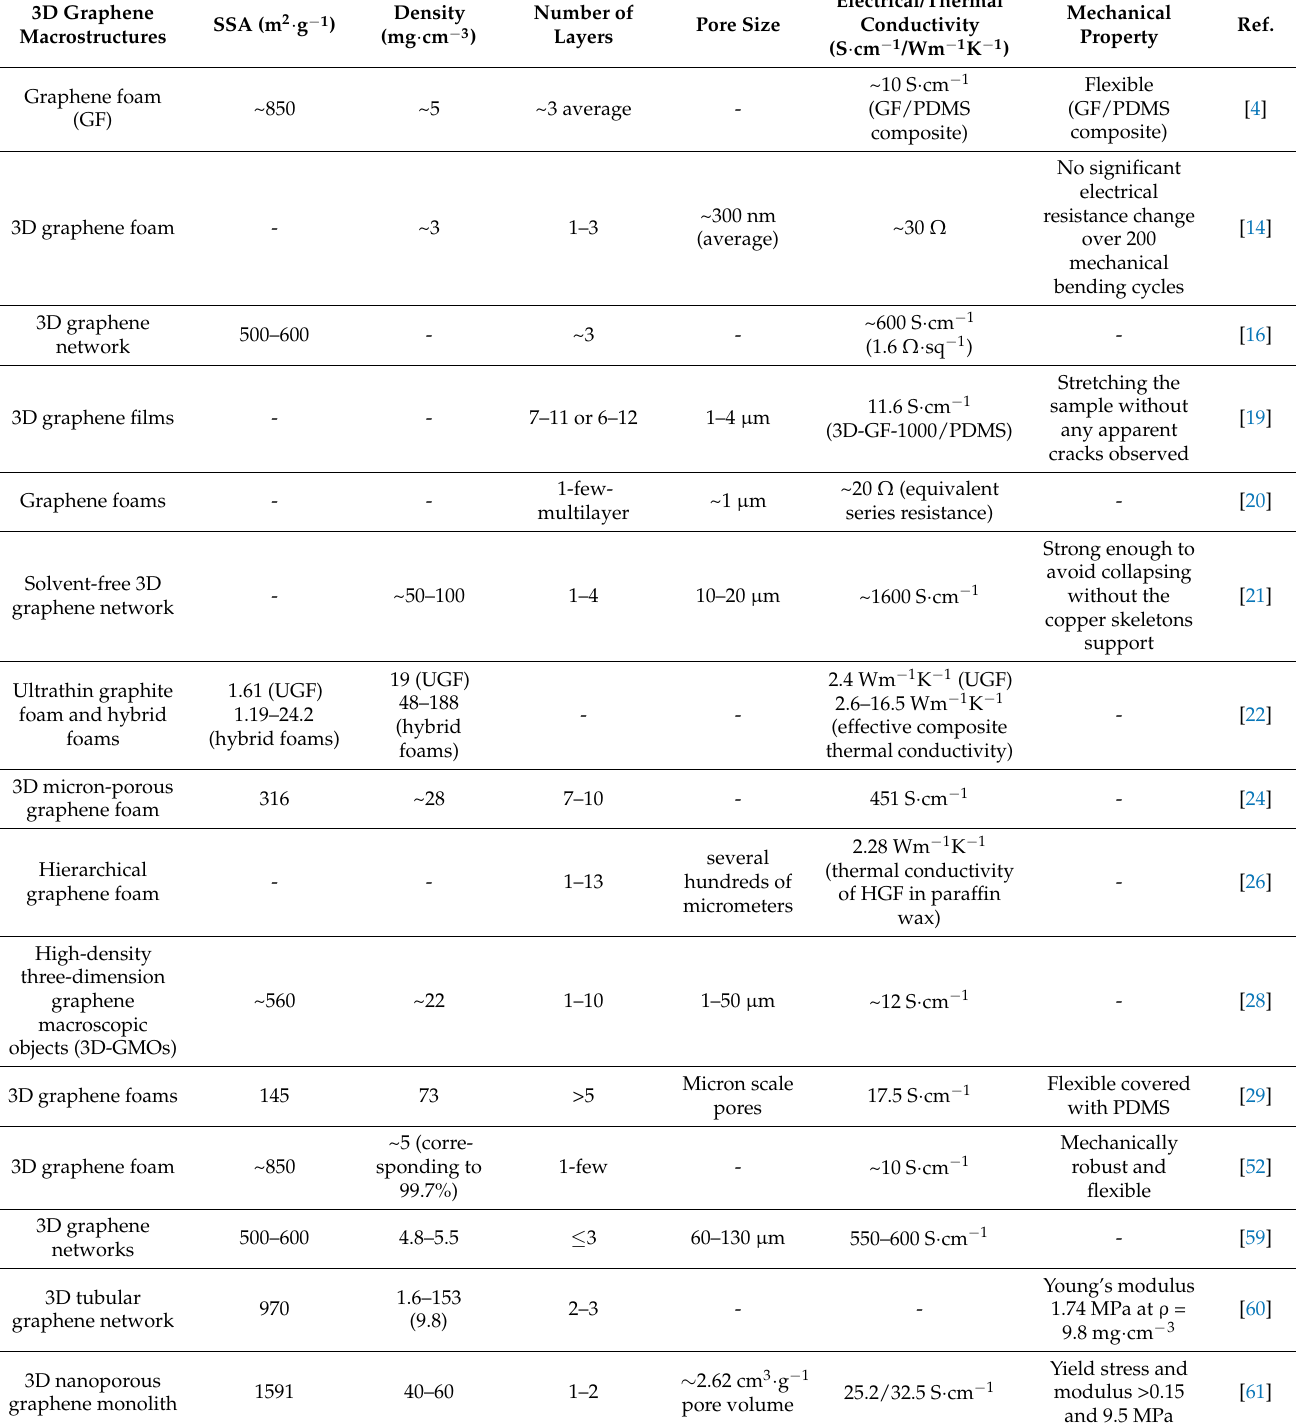
Table 2. The main properties of 3D graphene foams synthesized by